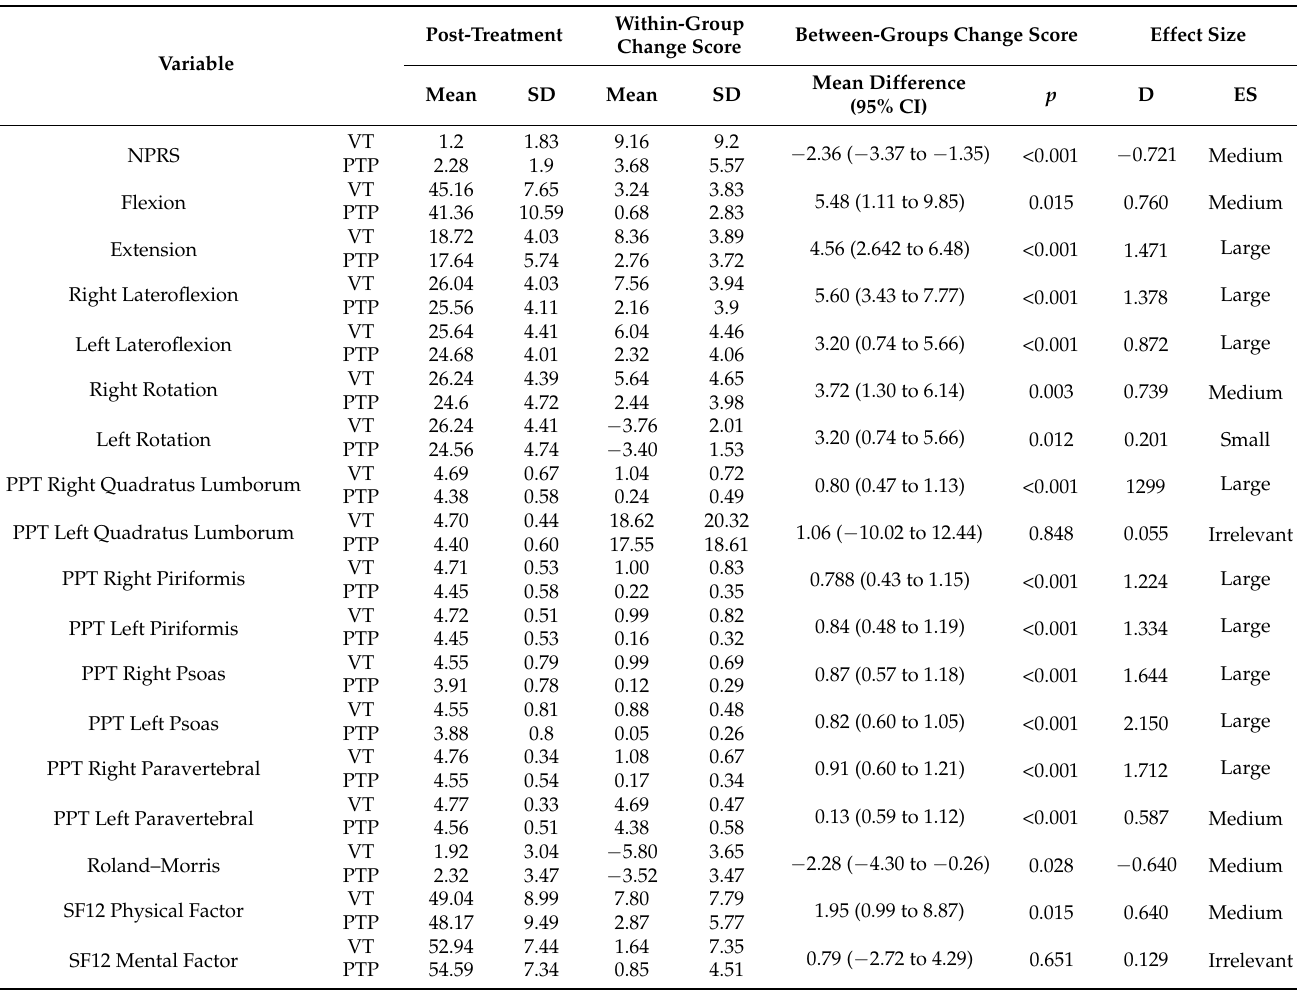
Table 3. Within-groups and between-groups differences in